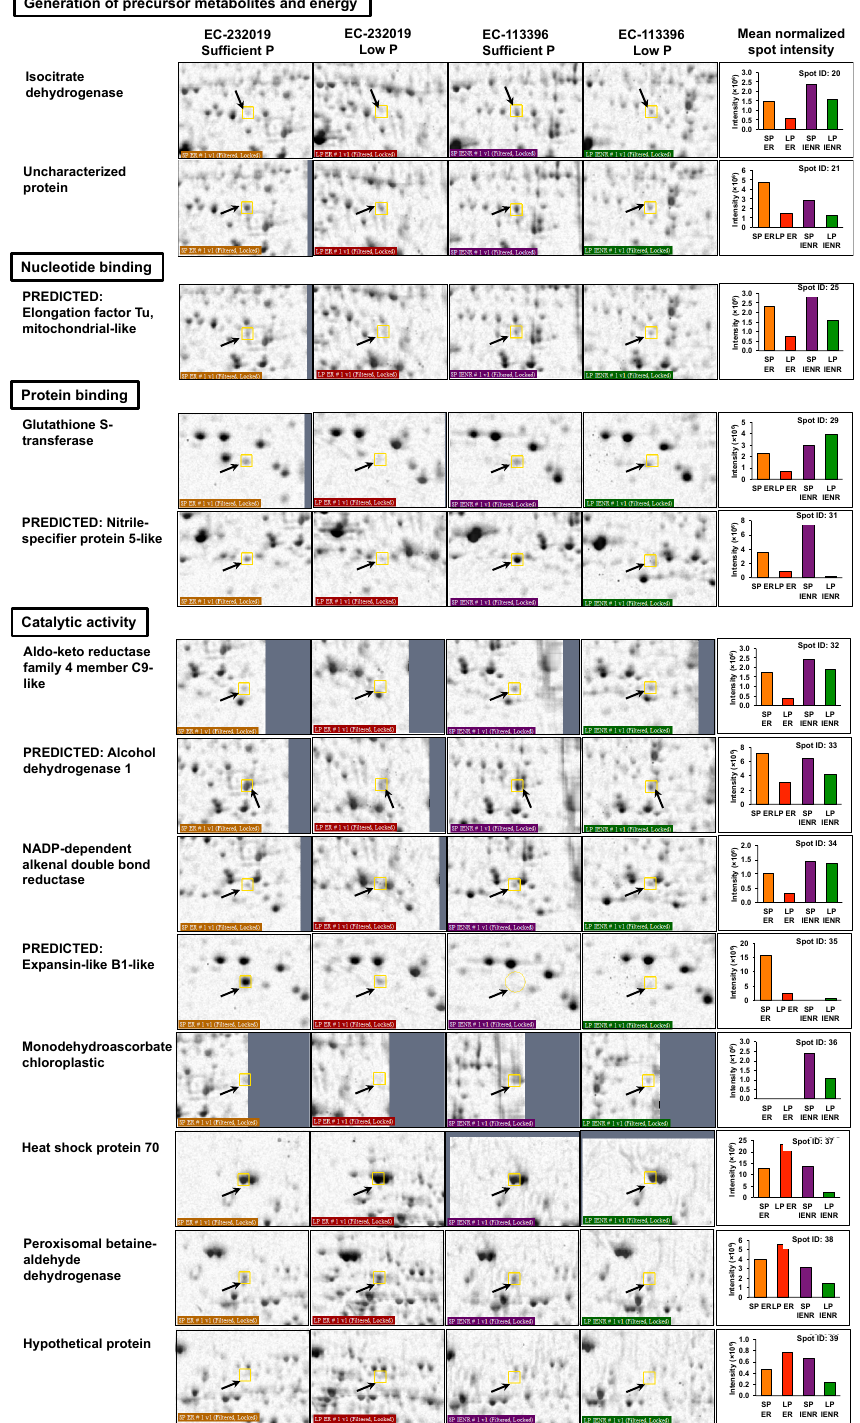
Figure 5. Root proteins decreased by more than two-fold at low (4 µ M) P in contrasting soybean genotypes. Arrows denote the protein spots zoomed for better visualization. Bars in the graph denote the mean ( n = 3) normalized intensity of protein spots on gels ofEC-232019 Sufficient P (orange, SP ER), EC-232019 Low P (red, LP ER), EC-113396 Sufficient P (violet, SP IENR) and EC-113396 Low P (green, LP IENR). Proteins with significant Mascot score are presented here. Refer Table 2 for entire list of decreased